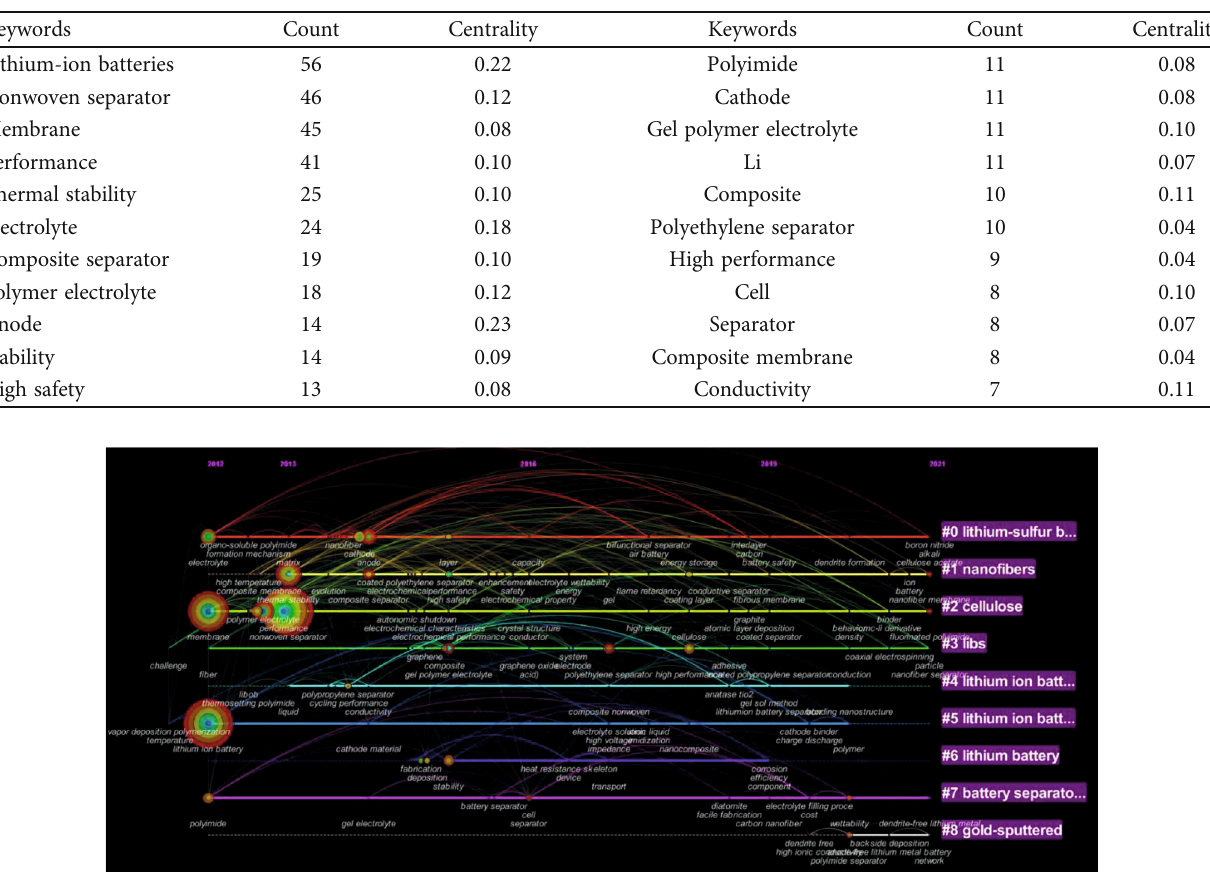
Figure 8: Timeline of keyword clustering analysis